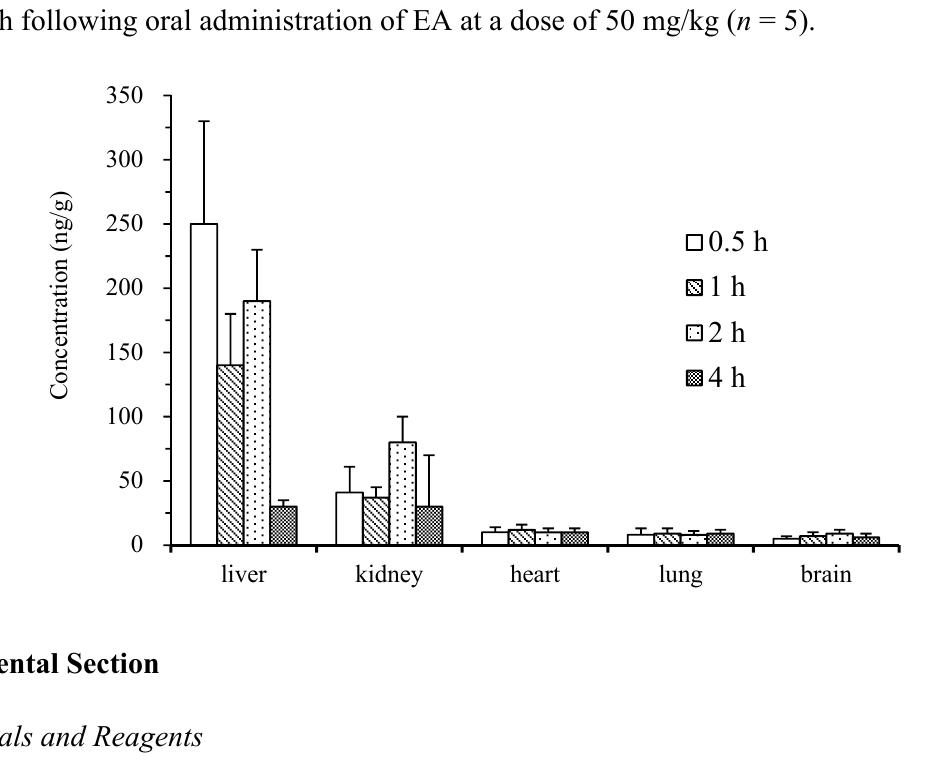
Figure 4. Distribution of ellagic acid in liver, kidney, lung, heart, and brain after 0.5, 1, 2, and 4 h following oral administration of EA at a dose of 50 mg/kg ( n =